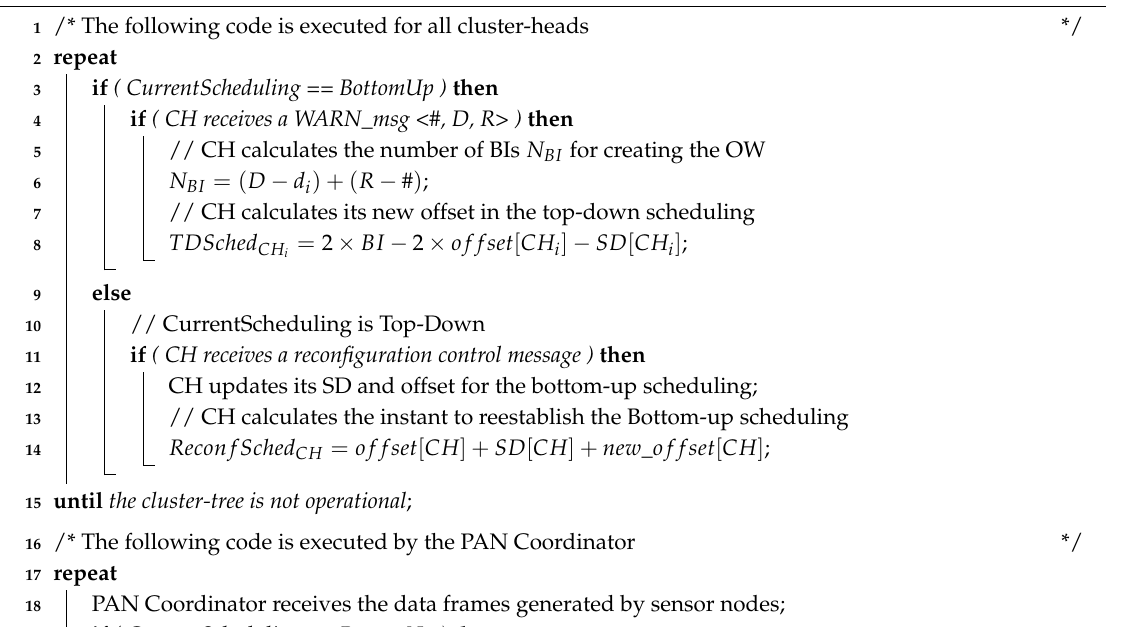
Algorithm 1: DyRET